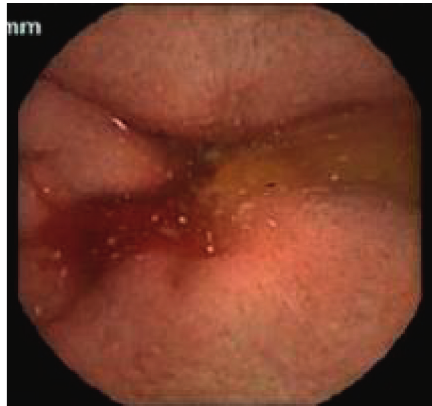
Figure 2: Intraluminal bleeding in the duodenum on video capsule endoscopy.